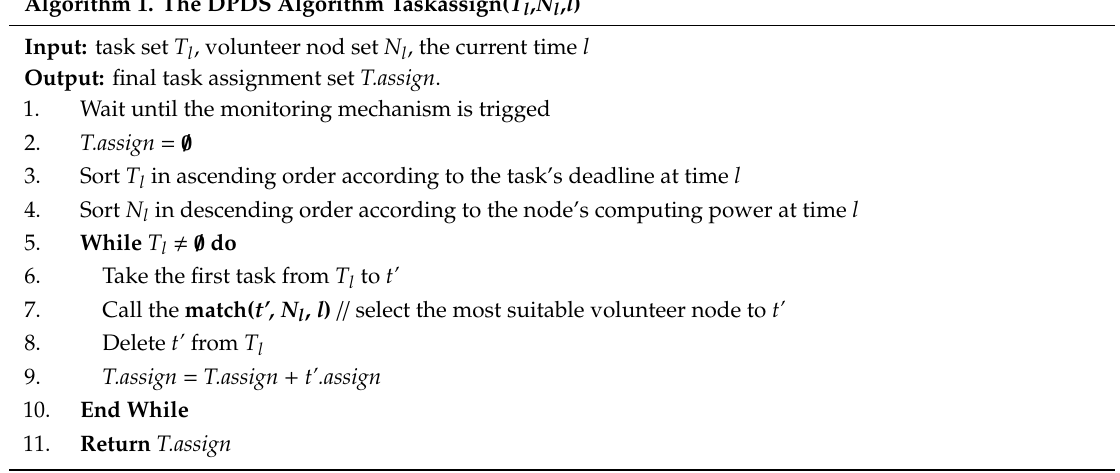
Algorithm 1. The DPDS Algorithm Taskassign( T l , N l , l